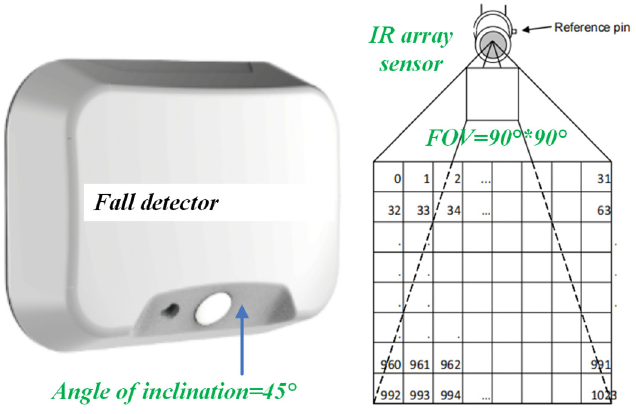
Figure 4. Fall detector is mounted on the sidewall at a height of 1.8 m.